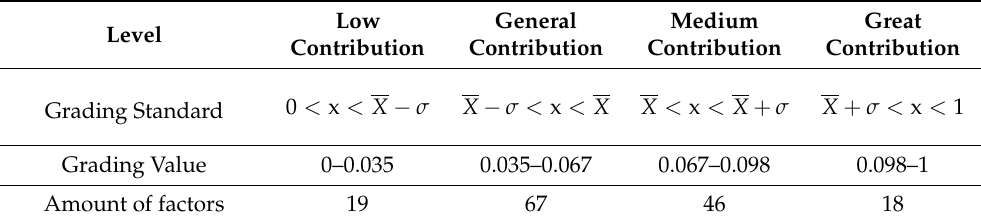
Table 6. Contribution grade standard of land use driving factors. X is the importance of the contribu- tion of each driving factor, X is the mean of all data and σ is the standard